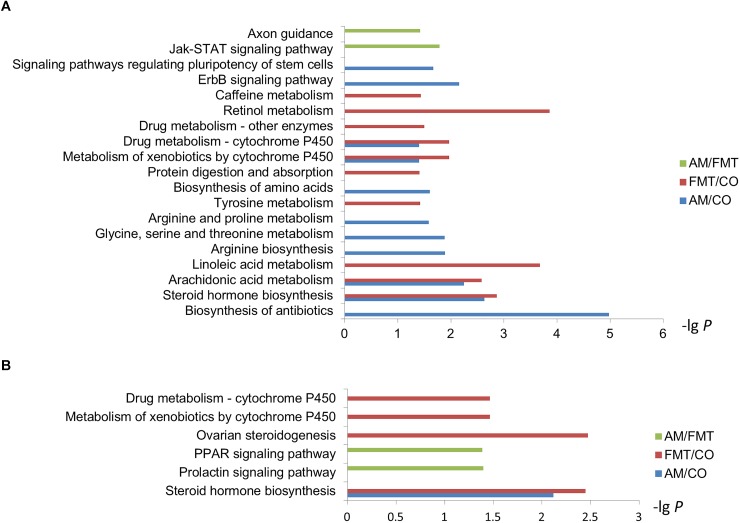
Kyoto Encyclopedia of Genes and Genomes pathway analysis of the DEGs in the livers among the AM, FMT and CO groups on day 7 (A) and day 21 (B).